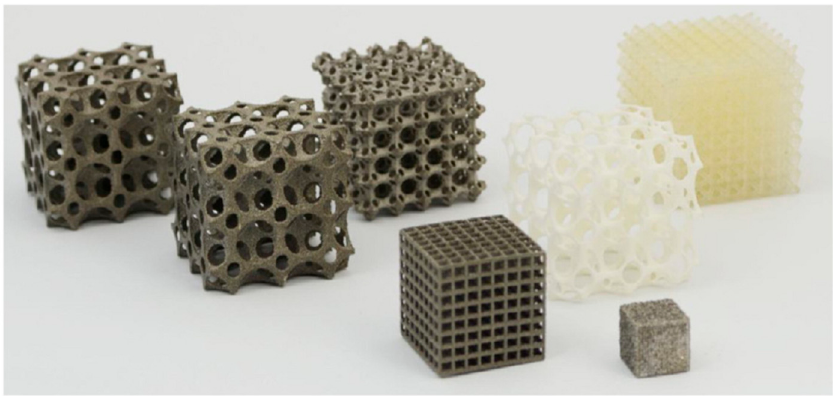
Figure 2. Examples of 3D scaffold structures manufactured using AM technology [11].